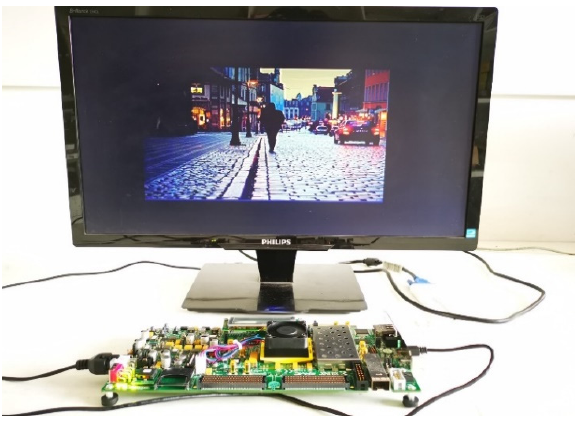
Figure 7. The experimental setup.